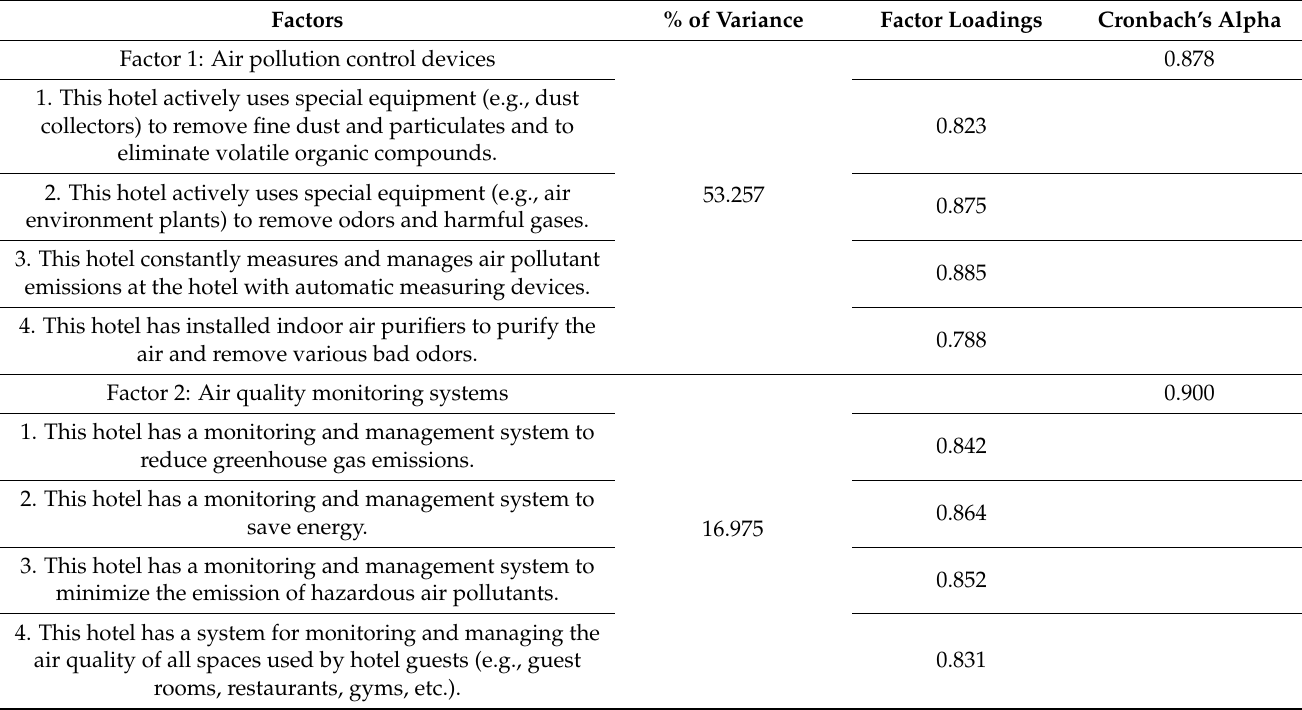
Table 1. Exploratory factor analysis